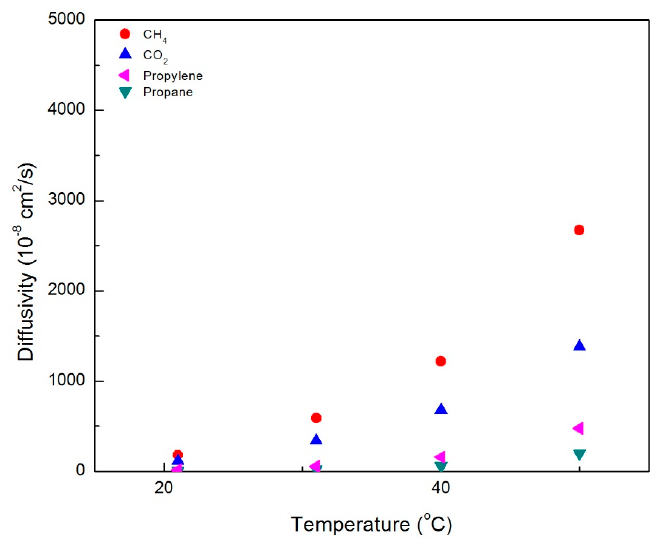
Figure A3. Diffusivity of various gases in the CNBPh75_5.0 membrane (5.0% crosslinker), plotted as a function of temperature in the nematic phases.